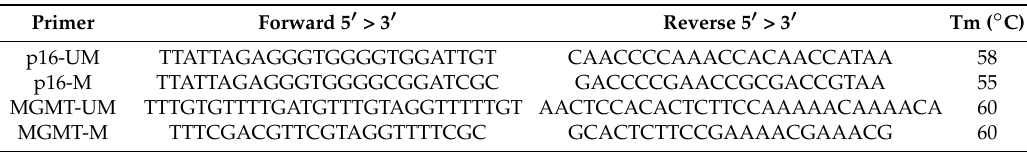
Table 4. Sequences of primers used in methylation-specific